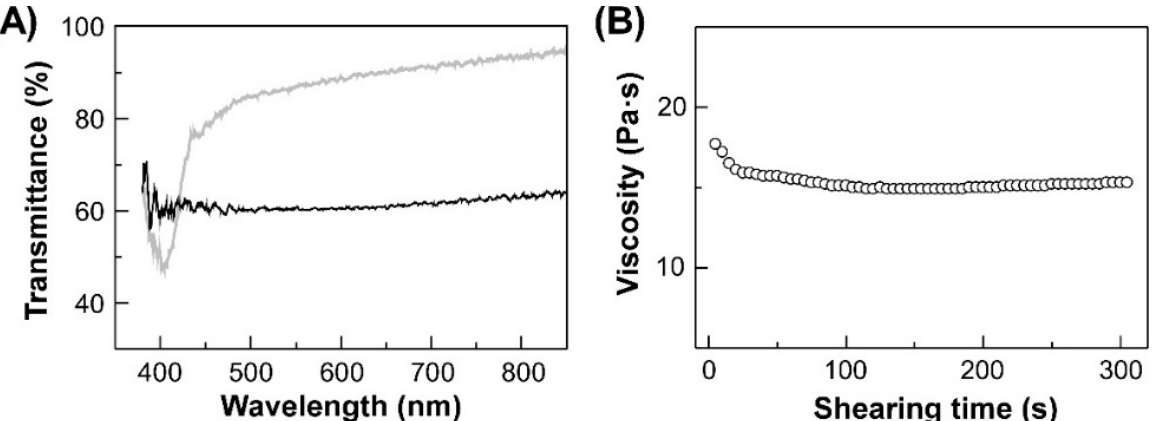
Figure 4. ( A ) Transmission spectra of the cell of HPC-PeEt before (gray line) and after (black line) the pre-heat treatment. ( B ) Changes in viscosity of HPC-PeEt as a function of shearing time. This measurement was performed at the constant shear rate of 1.0 s − 1 and at 25 °C.